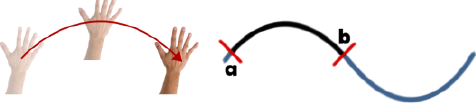
Figure 3. Definition of one movement as a segment of an equation.